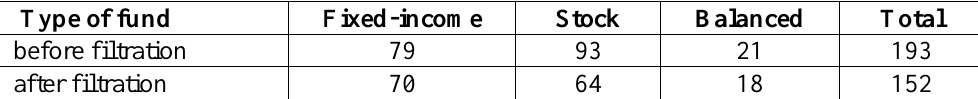
Table 1. Number of Understudy Mutual Funds Separated by Fund Type